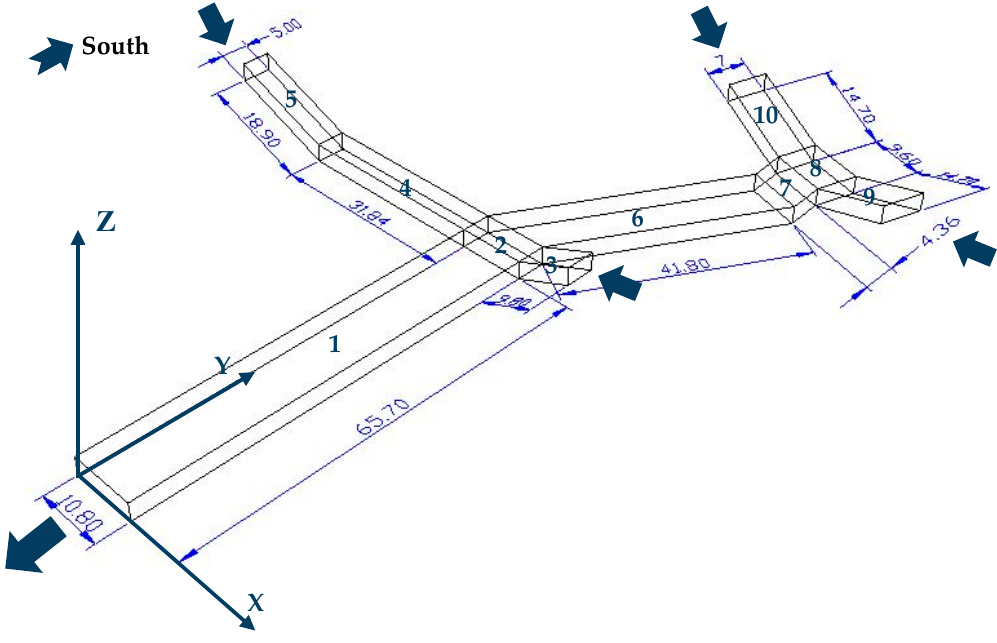
Figure 2. The structure of the selected passageway and the coordinate system. Each segment was assigned a label. Wind directions were marked with arrowheads.